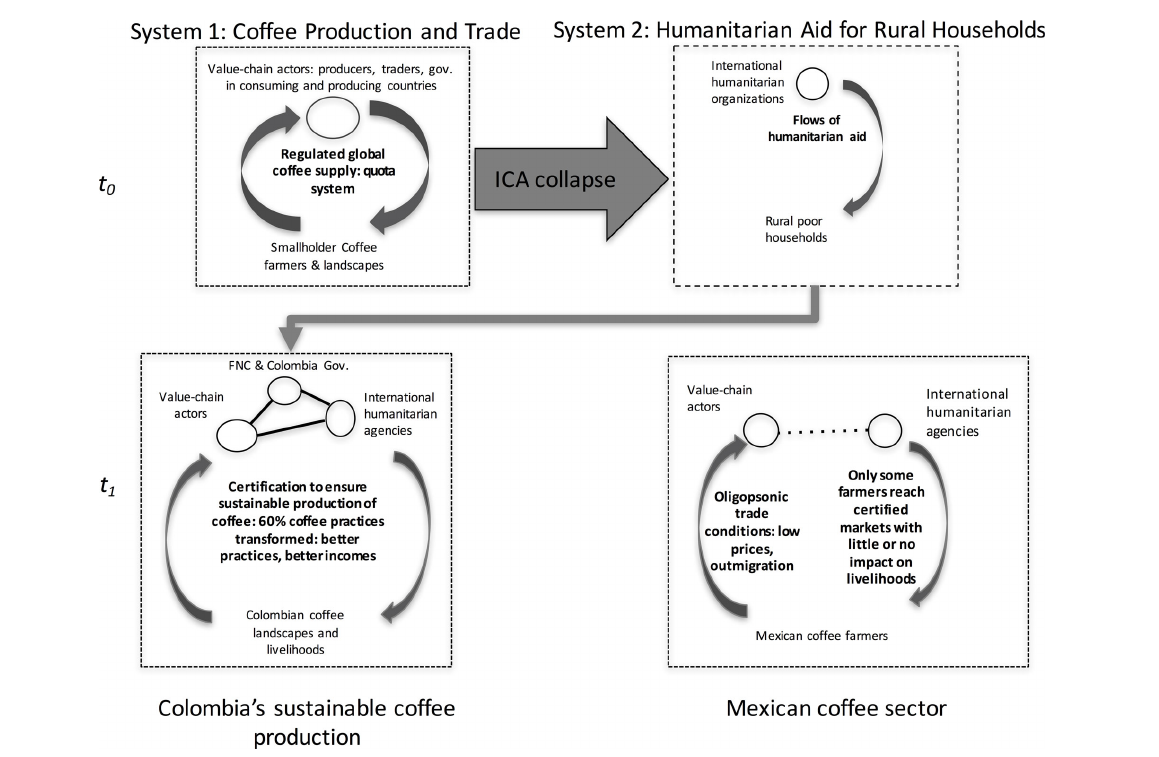
Fig. 4 . Telecoupling of the coffee system and international humanitarian aid networks: the case of Colombia. In t0, the global agro-economic coffee system operated with independent actors and institutions from the humanitarian aid system (type 3 telecoupling). In t1, the collapse of the International Coffee Agreement (ICA) provokes a change in actors, agendas, and institutions, as represented by the transformation of coffee governance in Colombia. The social-ecological coffee production system becomes governed simultaneously by local institutions, such as Colombian Coffee Growers Federation (FNC by its Spanish acronym) but also by distal governance systems (the environmental and humanitarian NGOs in North America and Europe). As noted in the text, this domestic transformation was not replicated in all countries: here we illustrate the case of Mexico for